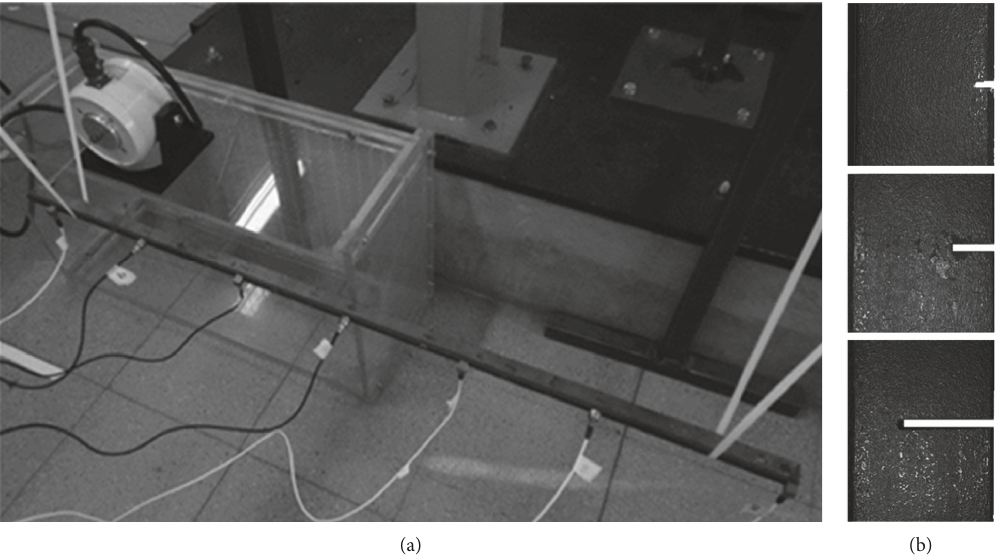
Figure 15: (a) Experimental beam setup [19]. (b) Example of saw cuts inflicted to the experimental beams [19].